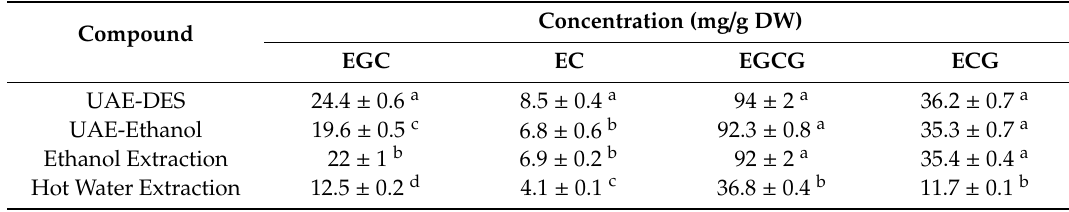
Table 6. Concentrations of four main catechins in the green tea extracts obtained by di ff erent extraction methods.